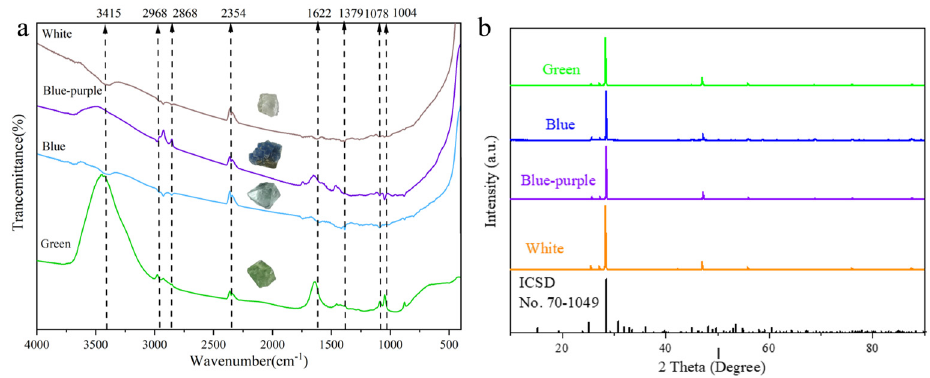
Figure 6. ( a ) IR spectra; ( b ) X-ray diffraction patterns of four color types of fluorite.